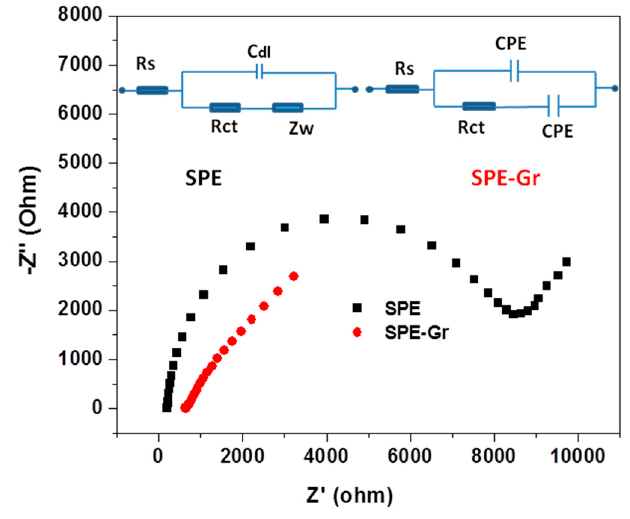
Figure 7. EIS spectra of SPE (black) and SPE-Gr (red) recorded in 1 × 10 − 3 M K 4 [Fe(CN) 6 ] solution (0.2 M KCl supporting electrolyte); Inset: equivalent electrical circuits of the electrochemical interface used to fit the impedance spectrum of SPE and SPE-Gr: R s —the solution resistance; Z w —the Warburg impedance; R ct —the charge-transfer resistance; C dl —double-layer capacitance; CPE—Constant Phase